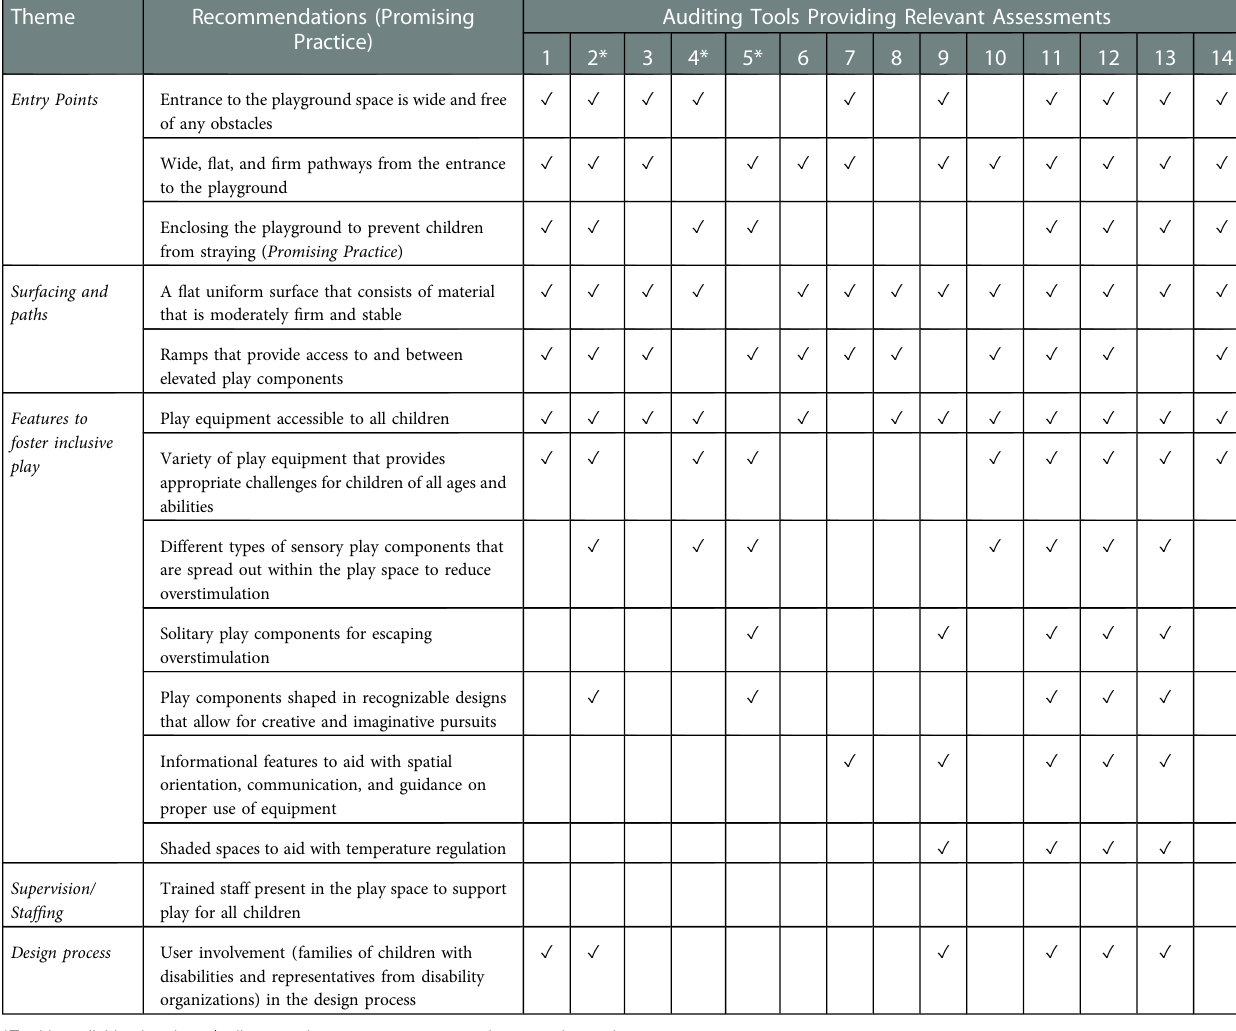
TABLE 3 Synthesis of auditing tool assessments into recommendations and ‘ promising practice ’ for playground